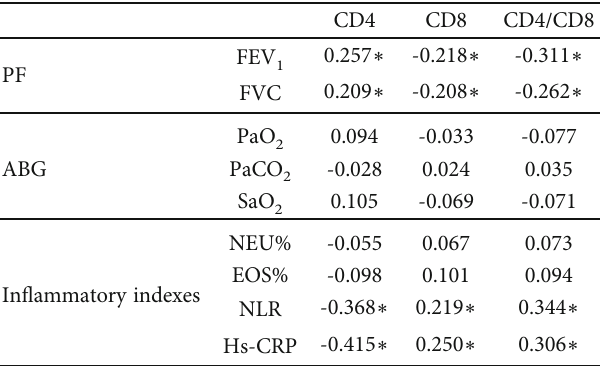
Figure 5: Comparison of CD 4+ and CD 8+ T lymphocyte subsets in PB. Note: (a) CD 4+ T lymphocyte subsets level; (b) CD 8+ T lymphocyte subsets level; in contrast with AECOPD group, the di ff erence was statistically meaningful, ∗ P < 0 : 05 . Table 2: Correlation analysis of CD4, CD8, and CD4/CD8 with various indicators in